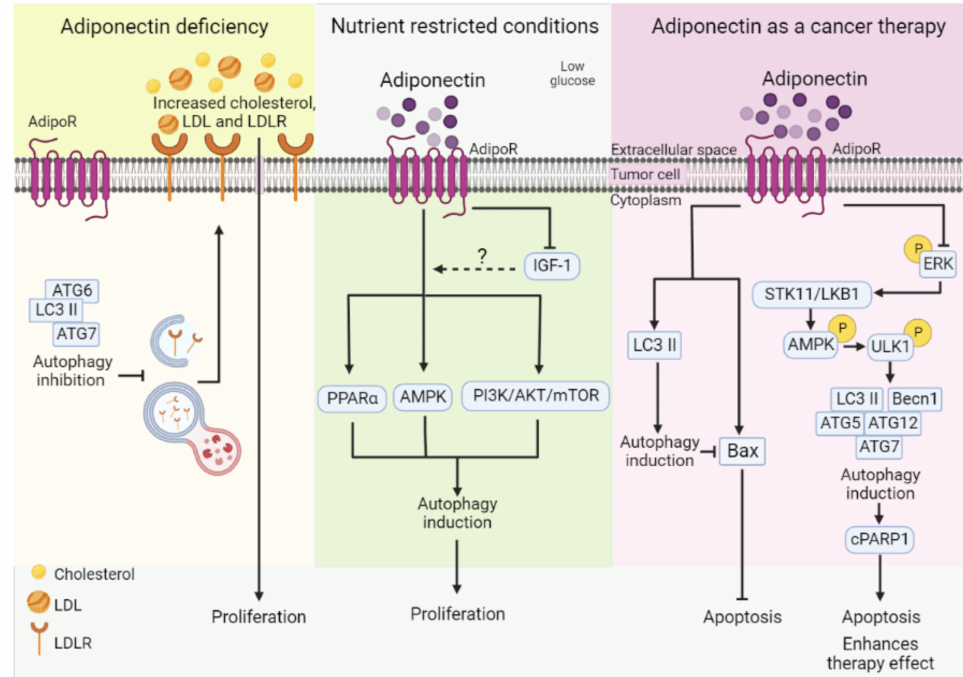
Figure 5. Regulatory mechanism of autophagy as determined by adiponectin and its different effects on cancer cell malignancy. Adiponectin deficiency reduces autophagy-related protein expression in primary tumor cells. A reduction in autophagy explains the increased cholesterol, LDL, and LDLR associated with accelerated tumor development in adiponectin deficiency conditions. This mechanism highlights autophagy as a possible pathway by which adiponectin deficiency might favor obesity-associated malignancies, especially breast cancer. On the other hand, supplying adiponectin has been proposed as a cancer therapy, particularly in obesity-associated cancer, since the addition of high levels of adiponectin to tumor cells induced autophagy and apoptosis. In this sense, it has been shown that adiponectin-induced autophagy negatively regulates apoptosis via the downregulation of Bax. Because autophagy inhibits adiponectin-induced apoptosis, it was suggested that the inhibition of autophagy would be an important therapeutic approach for enhancing the efficacy of cancer treatment with adiponectin. Additionally, it has been demonstrated that adiponectin- induced autophagy contributes to adiponectin-induced cancer cell death. Adiponectin inhibits ERK phosphorylation, which negatively regulates STK11/LKB1-AMPK activation. STK11/LKB1 leads to AMPK activation, which in turn increases ULK phosphorylation and induces autophagy. Adiponectin- induced autophagy was associated with the cleavage of PARP1 driven by